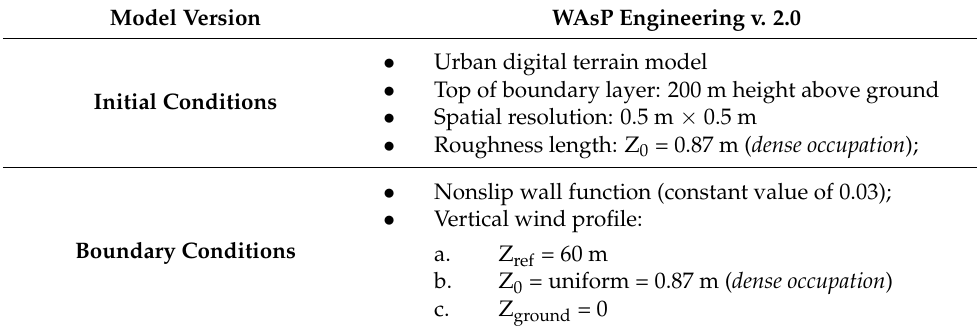
Table 1. Initial and boundary conditions imposed for the WAsP Engineering model.